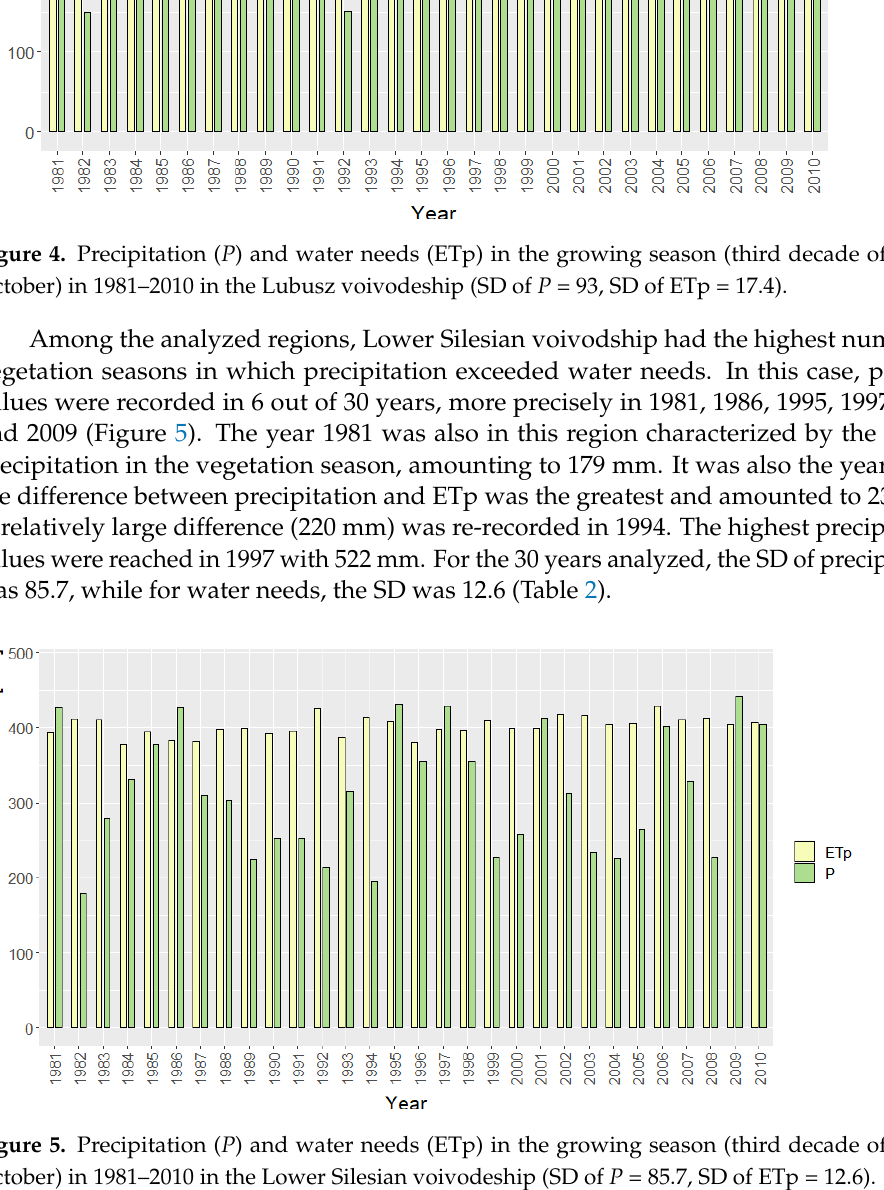
Figure 5. Precipitation ( P ) and water needs (ETp) in the growing season (third decade of May— October) in 1981–2010 in the Lower Silesian voivodeship (SD of P = 85.7, SD of ETp = 12.6). Analyzing the climatic conditions during 30 years (1981–2010) in the growing seasons for the three provinces, it can be seen that in most years in all voivodships the ETp values were higher than P . Only in a few years the situation was reversed, and interestingly for each province, there were different years in most cases. Looking at the graphs (Figures 3–5), one can conclude that conditions were unfavorable for willow cultivation in most years. A potential